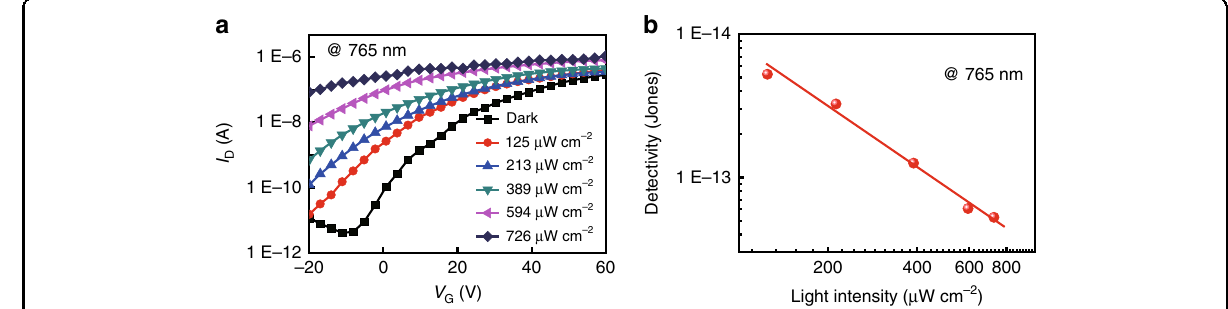
Fig. 5 The detectivity of the phototransistor. a Photocurrent responses of the TDPPQ-nanosheet-based phototransistor under 765 nm monochromatic light illumination with different light intensity. b Detectivity of a representative device under 765 nm monochromatic light